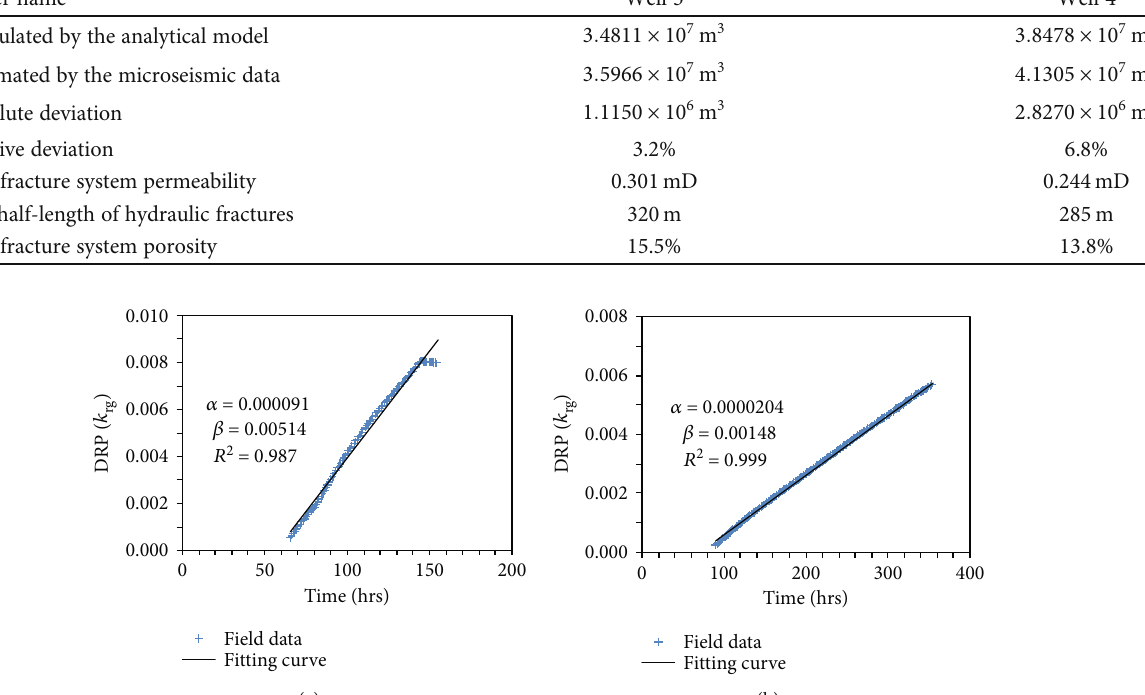
Figure 12: Dynamic relative permeability function over time without stress sensitivity for two wells belonging to southern Sichuan. (a) DRP for Well 3. (b) DRP for Well 4.